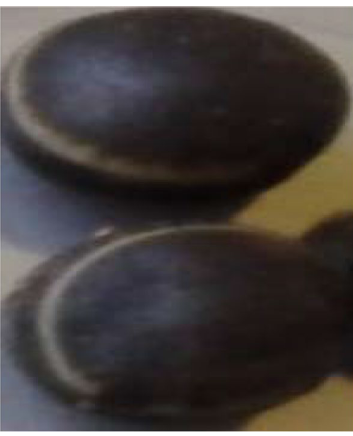
Fig. 1 Typical example of Mucuna